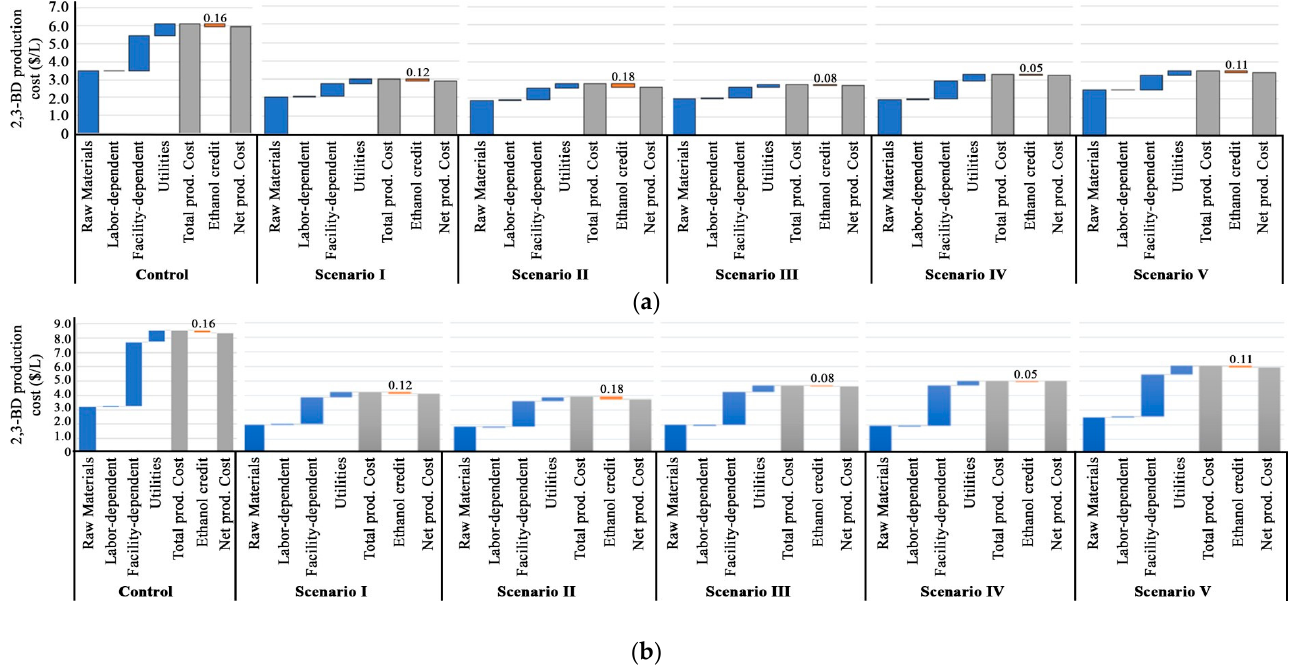
Figure 6. 2,3-BD production costs using P. polymyxa in ( a ) without distillation and ( b ) with distillation (Note: The blue bars represent itemized production costs; orange bars represent ethanol credits and gray bars represent gross production costs). Ctrl A medium (Table 1 treatment C—Control), 5 g/L FSBC + organic nitrogen (Table 1 treatment B—scenario I), 5 g/L PLBC + organic nitrogen (5- in Table 1 treatment B—scenario II), 75% ADE + 10 g/L FSBC (Table 1 treatment C—scenario III), (Table 1 treatment A—scenario V). Collectively, our data show that replacing elemental nutrients in the 2,3-BD production medium with ADE and biochar can improve 2,3-BD production and reduce the overall 2,3-BD production cost. Table 8. Production costs of different 2,3-BD production